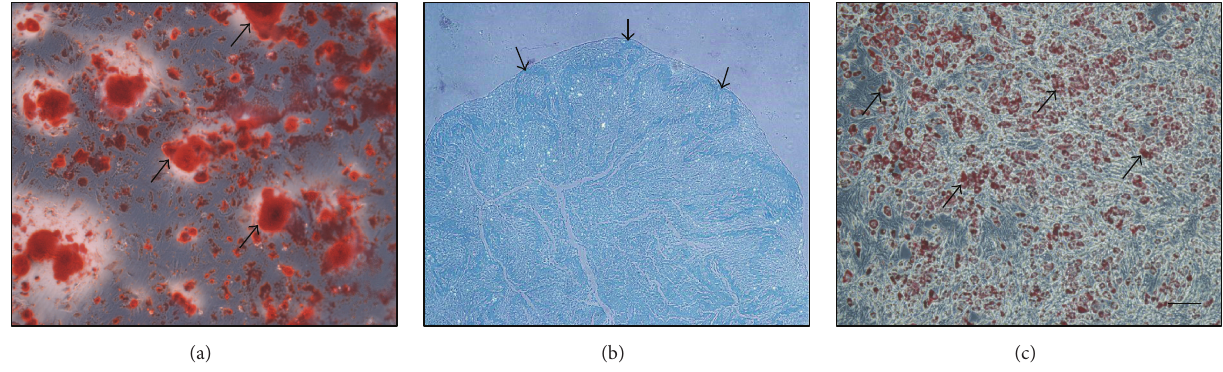
Figure 1: Light micrographs depicting the (a) osteogenic, (b) chondrogenic, and (c) adipogenic differentiation of multipotent BMSCs. The black arrows indicated the red-stained mineralized nodules in (a), blue-stained chondrogenic cell pellet in (b), and red-stained lipid droplets in cells in (c). Bar = 100 𝜇 m.